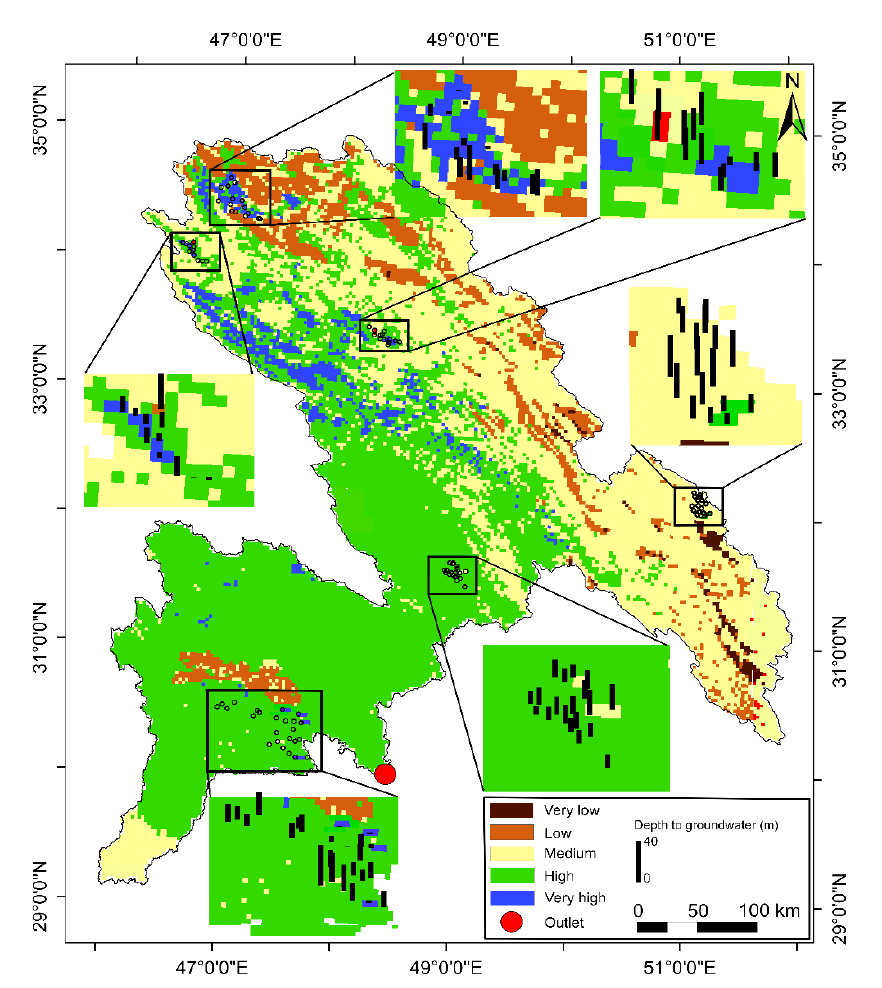
Figure 4. Projection of depth to groundwater of wells on the GWPZs map.